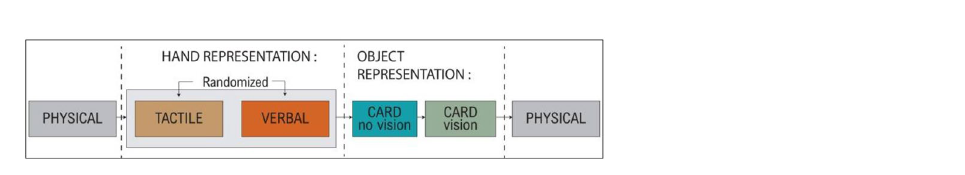
Figure 2. Design of the experiment: 3 conditions concerning the measure of the hand representation (PHYSICAL, TACTILE, VERBAL) and 2 concerning the representation of an object in external space as control (CARD-no vision,